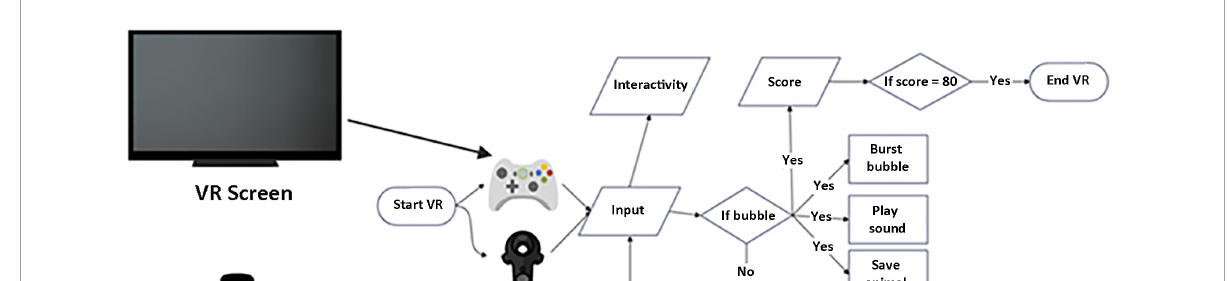
FIGURE2 A screenshot of VR Animal Rescue World.